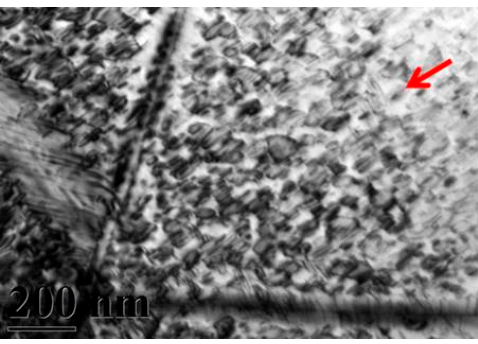
Figure 6. Bright ‐ field TEM image of the specimen aged at 500 °C for 4 h (Sample D).